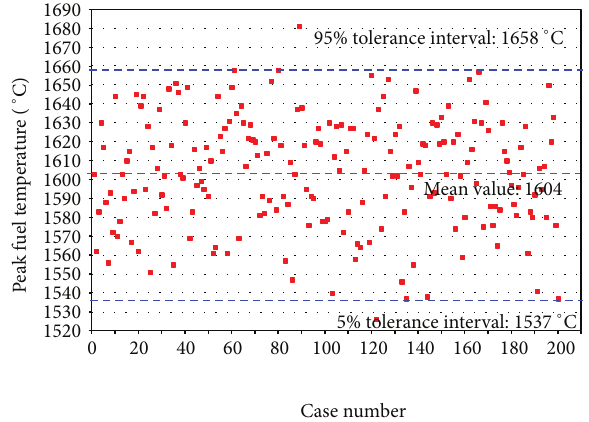
Case number F 8: Peak DLOFC fuel temperature of the 200 LHS Normal set at 50 hours. F9:NormalizedpeakDLOFCfueltemperaturehistogramsfor the 200 LHS and SRS Normal